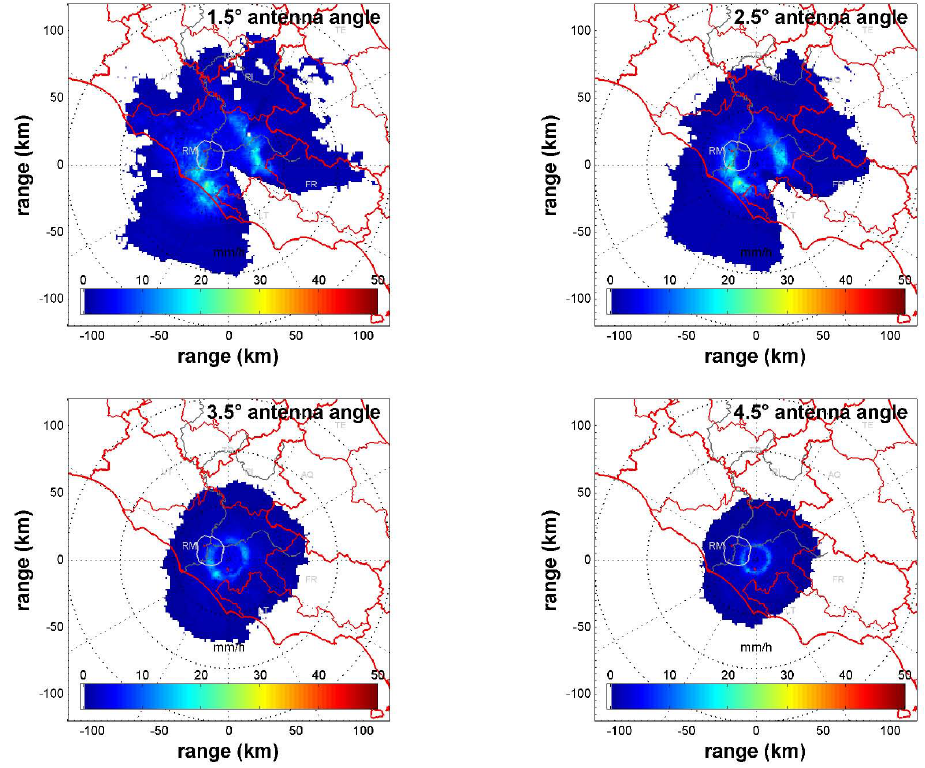
Fig. 7. Rain rate (mmh − 1 ) maps obtained during a volume scanning at 03:10 a.m. during the stratiform event of 12 December 2008. Note that sector delimited by azimuth 130 and 150 ◦ is screened by nearby hills.